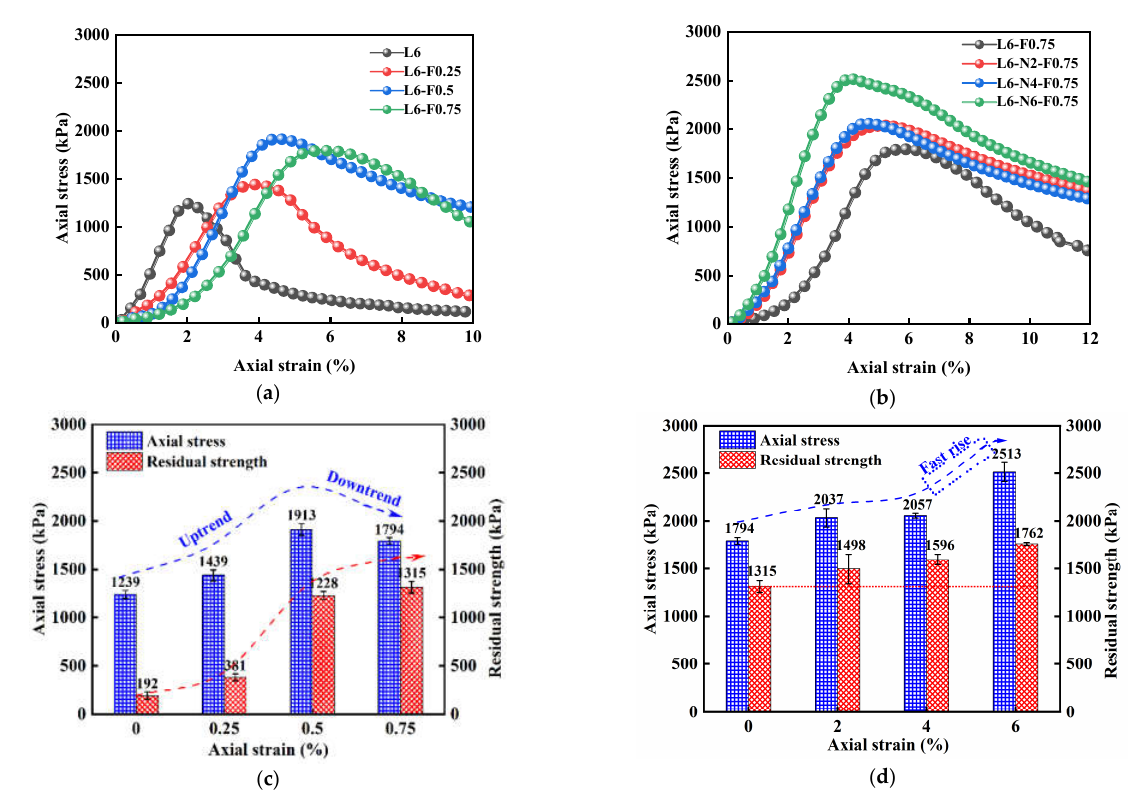
Figure 5. Effect of nano clay on the statics of NFLS: ( a ) stress – strain curve of FLS; ( b ) stress – strain curve of NFLS (F = 0.75%); ( c ) UCS and residual strength of FLS; ( d ) UCS and residual strength of NFLS (F = 0.75%).